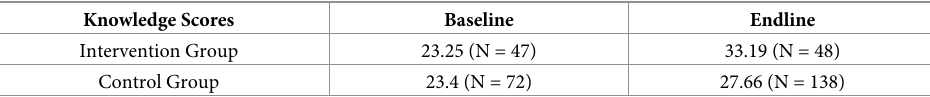
Table 1. Mean knowledge